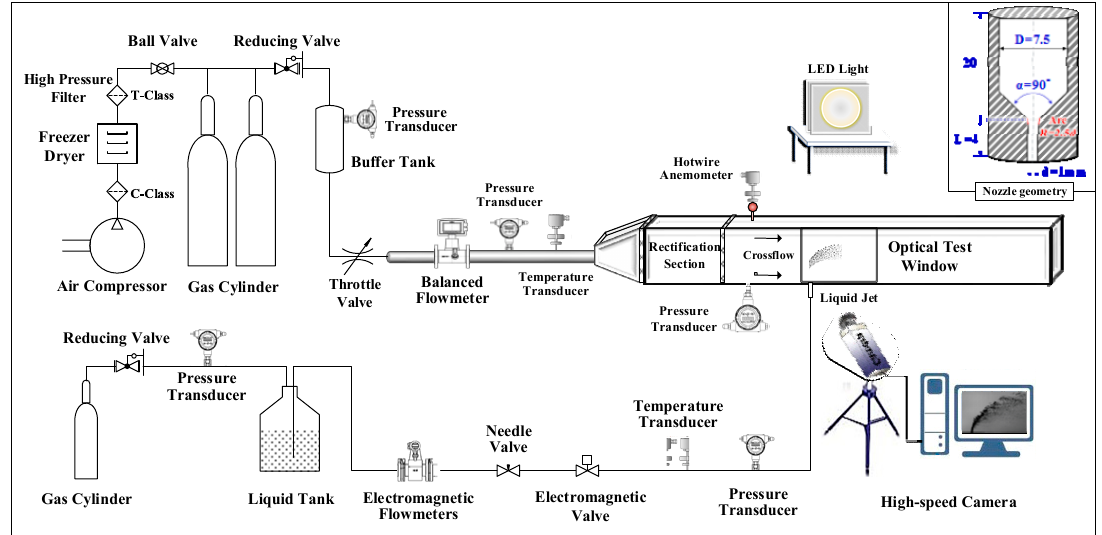
Figure 3. Experimental setup for studying the liquid jet in the crossflow.